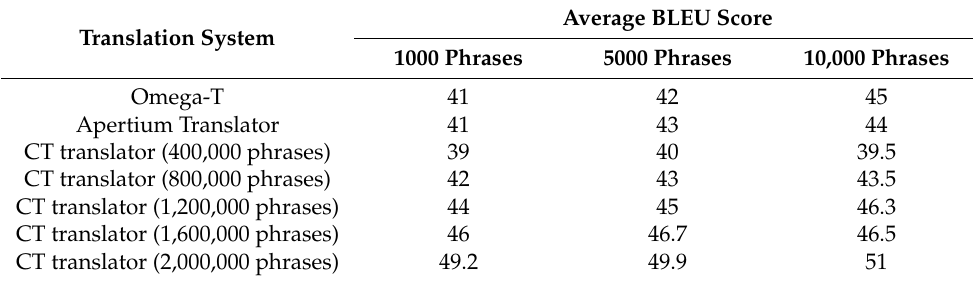
Table 3. Automated evaluation using BLEU Score, for the English-Arabic corpora.